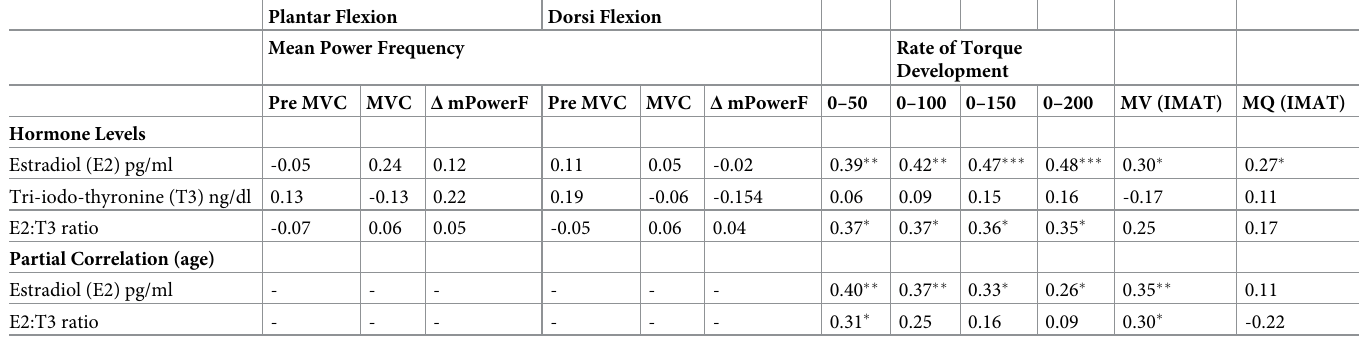
Table 5. Bivariate and partial (correcting for age) Spearman correlations between hormone levels against electromyography mean power frequency (pre, during, change) and rate of torque